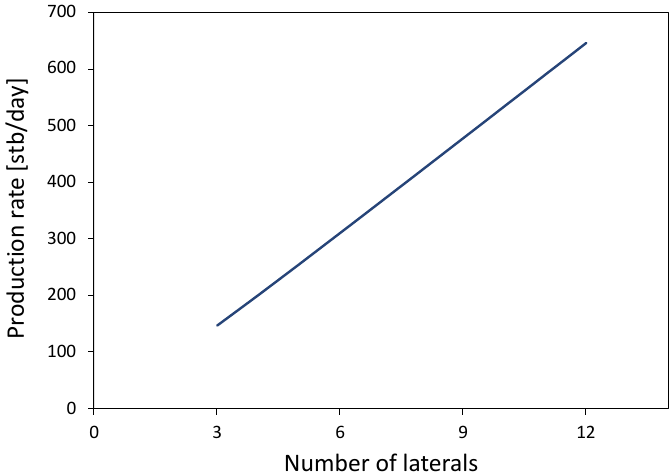
Figure 10. Modeled effect of the number of laterals on well production rate (Well #1).